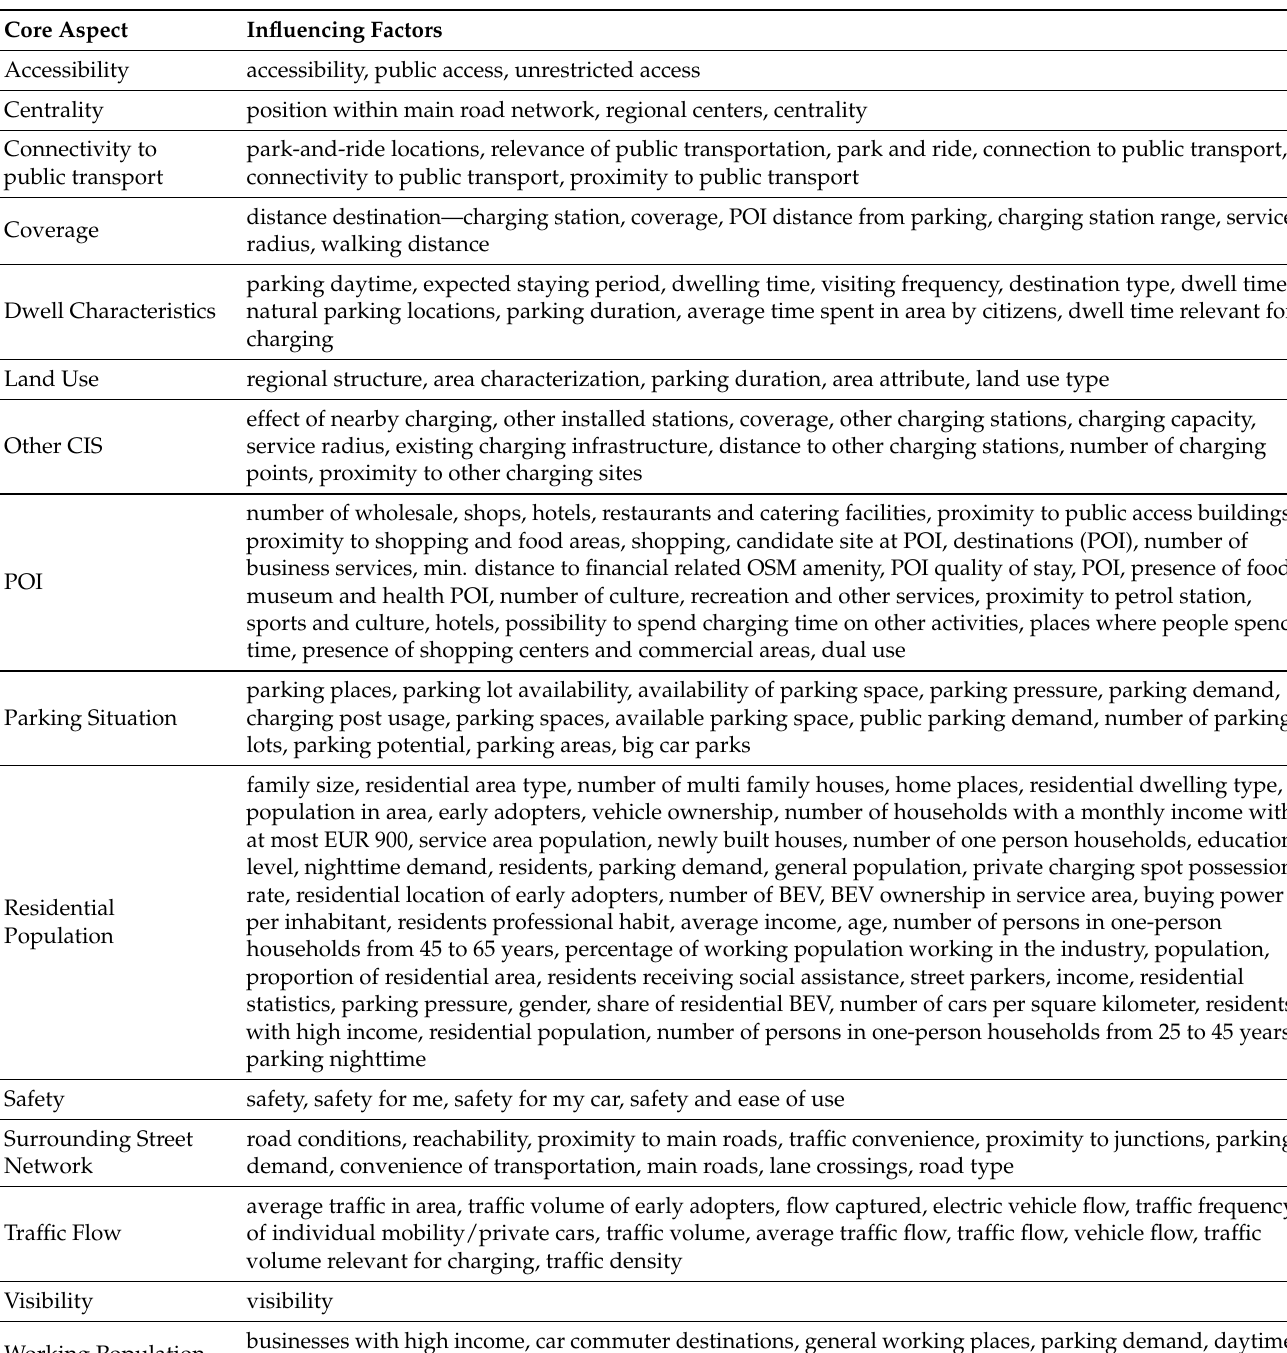
Table 3. Influencing factors mentioned per core